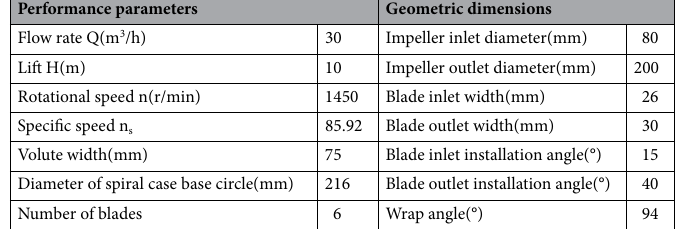
Table 2. Design parameters for closed plastic impellers.